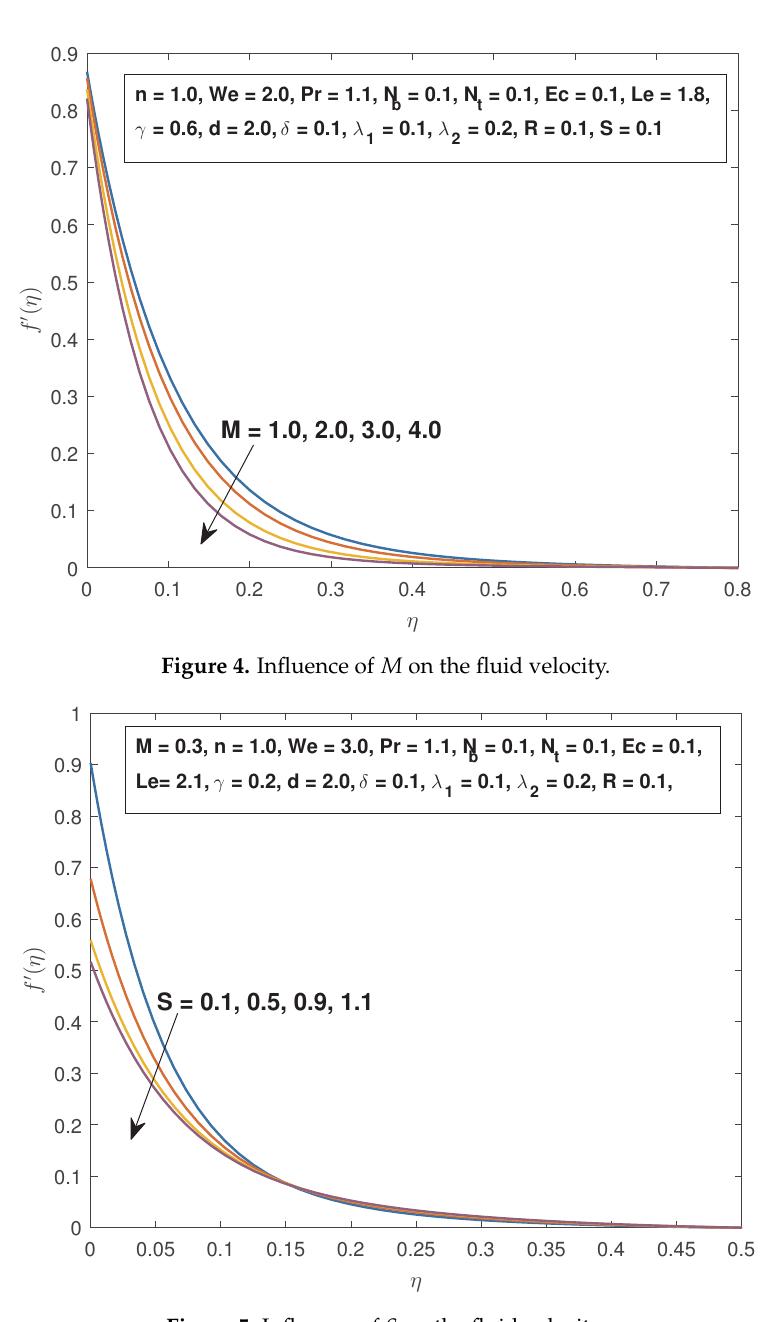
Figure 5. Influence of S on the fluid